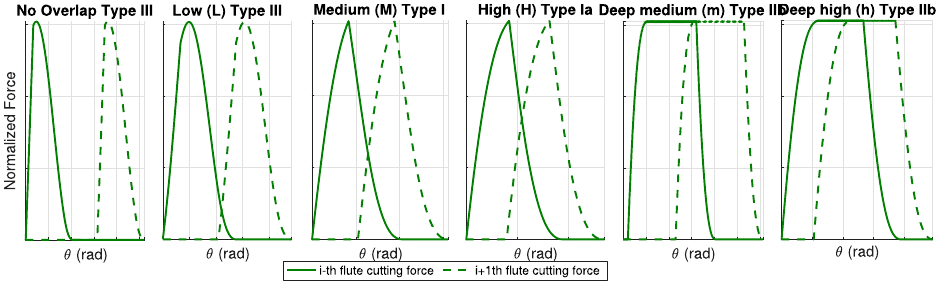
Figure 4. Example of multiple flutes endmill F shape for both down-milling and up-milling.